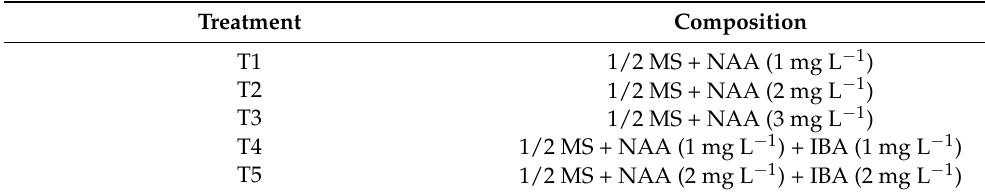
Table 3. Media composition for root